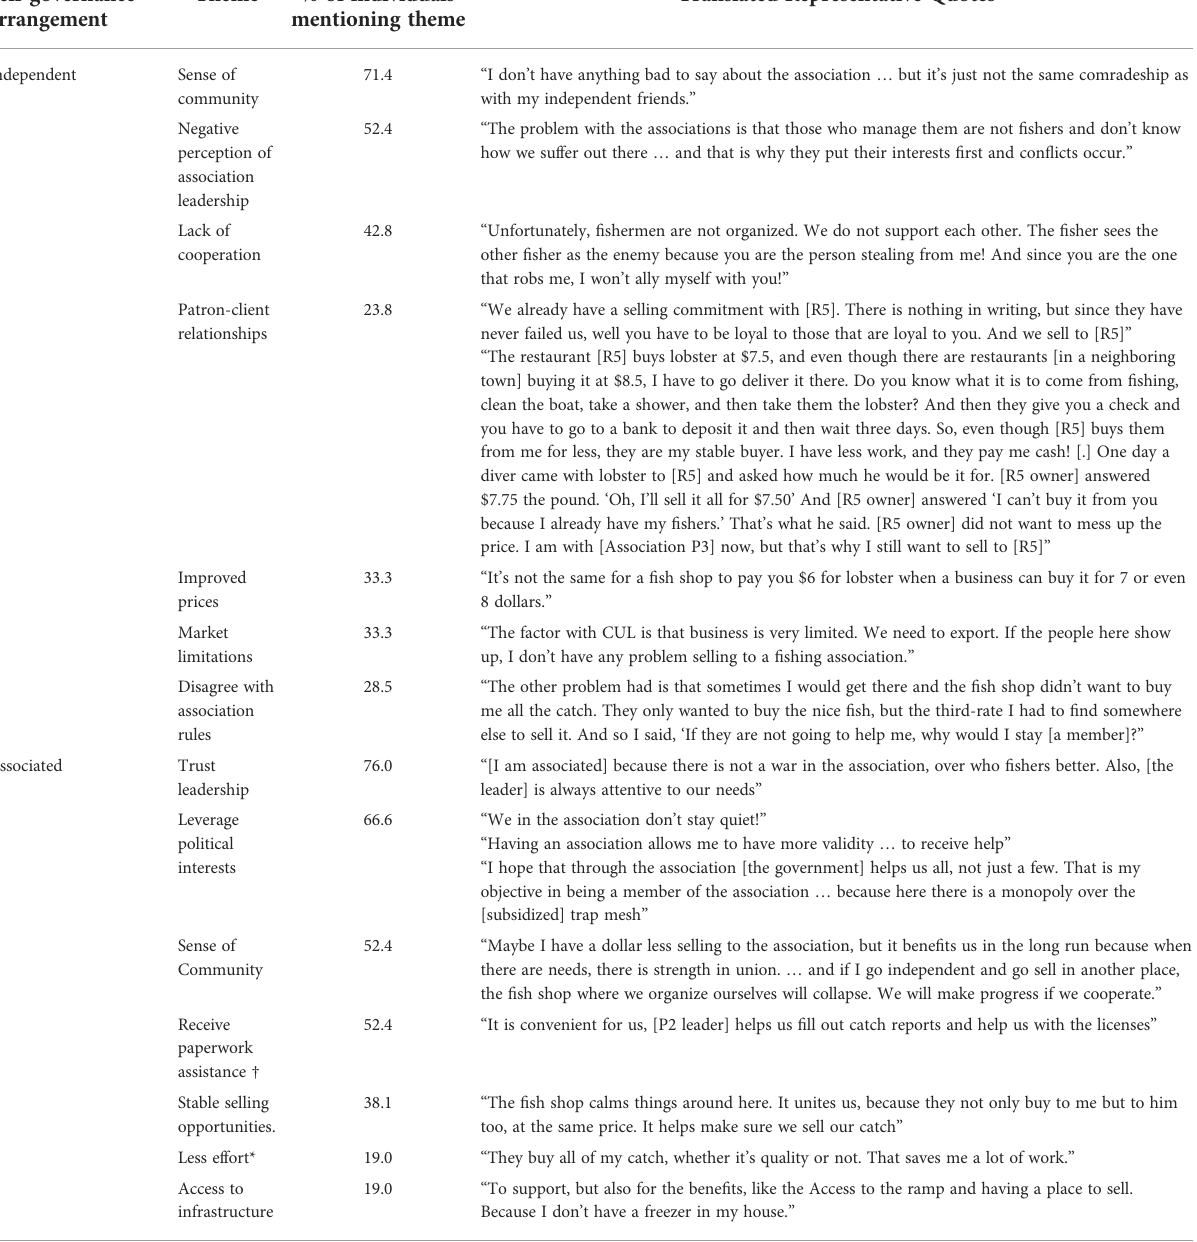
TABLE 3 Commercial fi sher ’ s reasons for choosing self-governance arrangements emergent from coding and analyzing semi-structured interviews (n = 21).